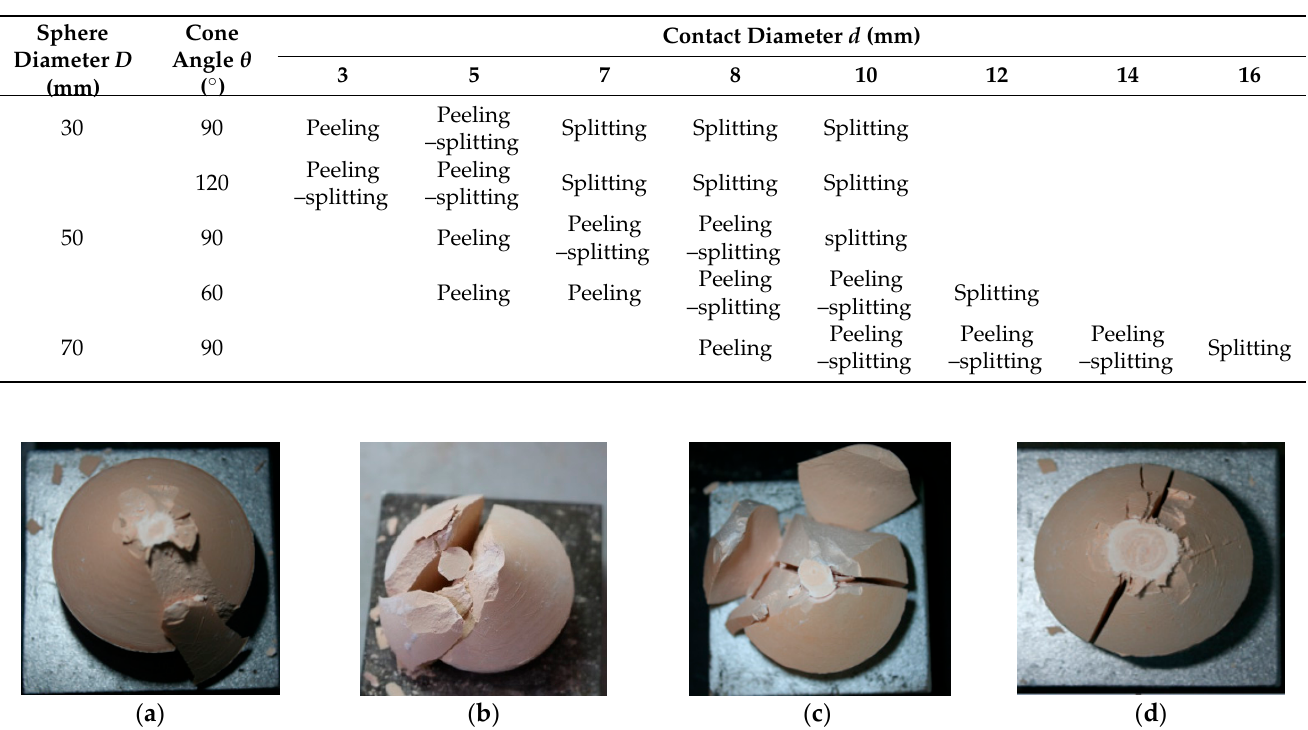
Figure 8. Breakage modes change with the increase in contact diameter d when the sphere diameter D is 50 mm and cone angle θ is 90°: ( a ) d = 5 mm; ( b ) d = 7 mm; ( c ) d = 8 mm; ( d ) d = 10 mm. Table 3. Particle breakage modes.